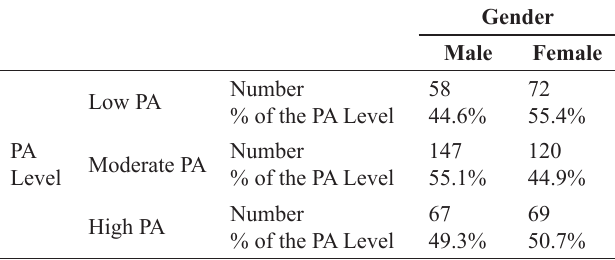
Figure 3. Throw and catch